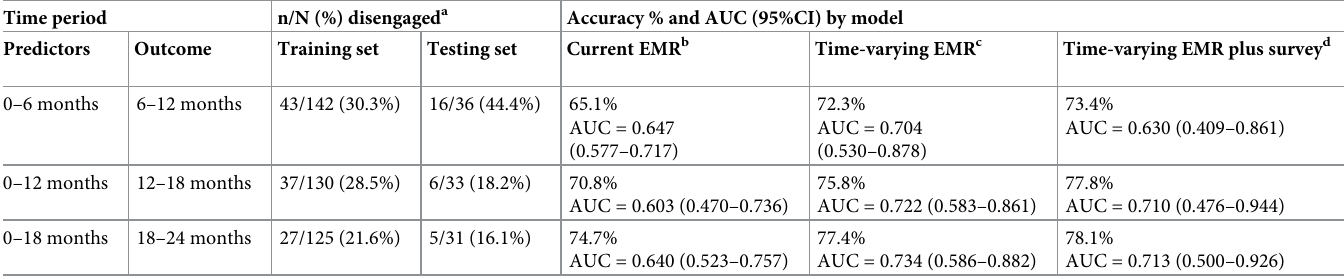
a Number of individuals disengaged during the outcome period out of the total number of individuals included in the model, after removing deaths and dropouts (over 6 months since the last missed visit). Individuals were randomly split into 80% training and 20% testing sets. b Using the most recent EMR value only.